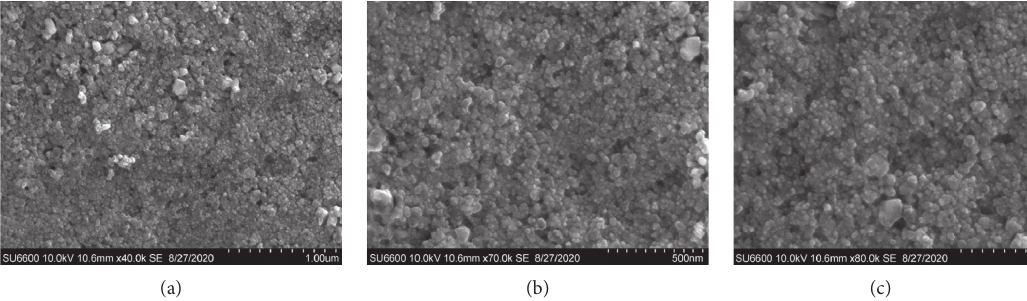
Figure 10: SEM image of the synthesized PF AgNPs. (a) x40 k/scale - 500nm; (b) x70 k/scale - 500nm; and (c) x80 k/scale -